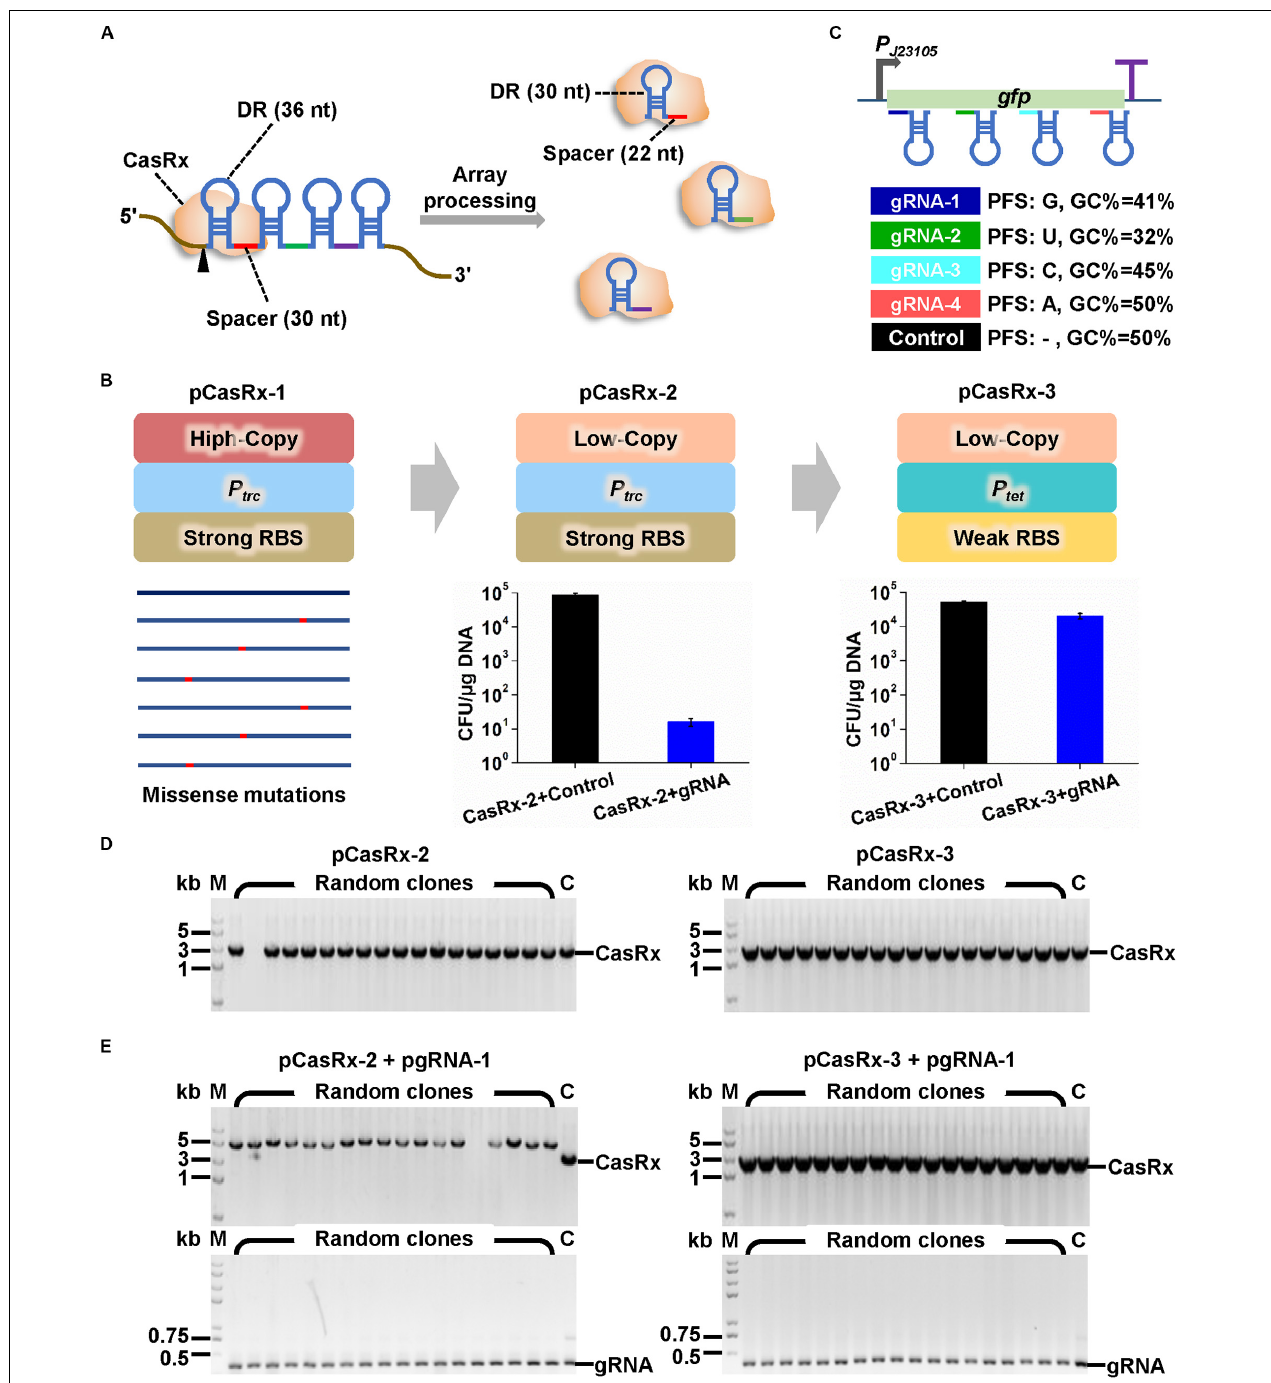
FIGURE 1 | Construction of microbial expression systems for CRISPR/CasRx. (A) Multiple gRNAs containing a 30-nt spacer flanked by two 36-nt DRs can be expressed as a single array and processed by CasRx into individual mature gRNAs containing 30-nt DR and 22-nt spacer. (B) Strategies to construct casRx expression plasmid for E. coli . The high copy number pUC replicon was first replaced with a low copy number pSC101 replicon. An IPTG inducible promoter P tac and a strong RBS (AAAGGAGTTGAGA) were then replaced with a Tc inducible promoter P tet and a weak RBS (AAAGGCACCCGAT). To determine plasmid transformation efficiency, E. coli harboring pGFP was co-transformed with a casRx expression plasmid (pCasRx-2 or pCasRx-3) and an empty plasmid with no gRNA cassette (control) or a gfp -targeting gRNA expression plasmid (pgRNA-1). Cells were plated on LB solid plates supplemented with Amp + Cm + Kan. Clones were counted after 24 h cultivation. (C) Design of four gfp -targeting pre-gRNAs with different characteristics and a non-targeting control with no target site on the whole E. coli and C. glutamicum transcripts. (D) Clone PCR verification of transformants of pCasRx-2 or pCasRx-3. M, DNA marker; C, plasmid positive control. (E) Clone PCR verification of transformants of pCasRx-2 + pgRNA-1 or pCasRx-3 + pgRNA-1. M, DNA marker; C, plasmid positive control.